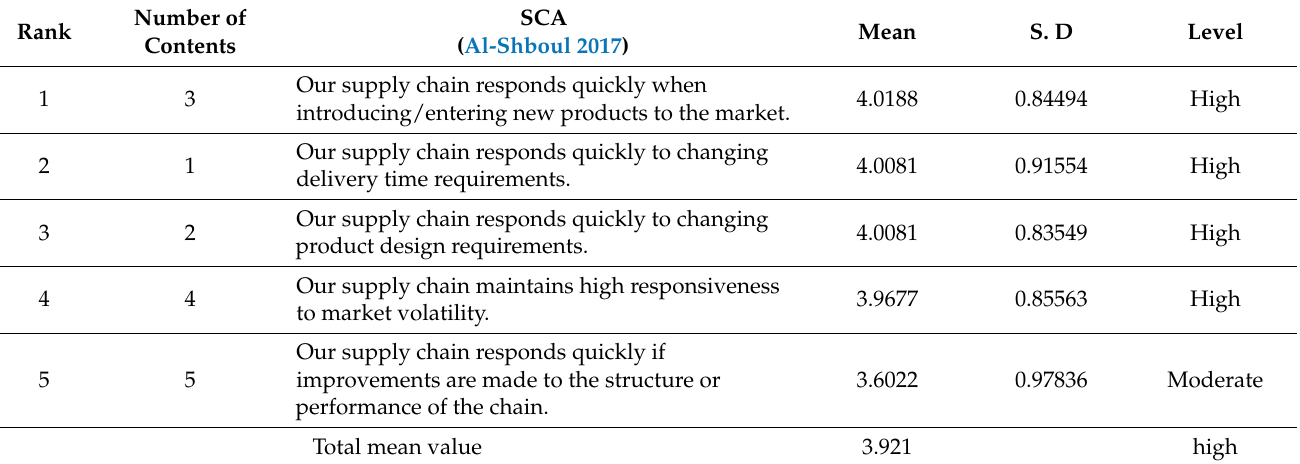
Table 2. SCA Measurement (N = 372).